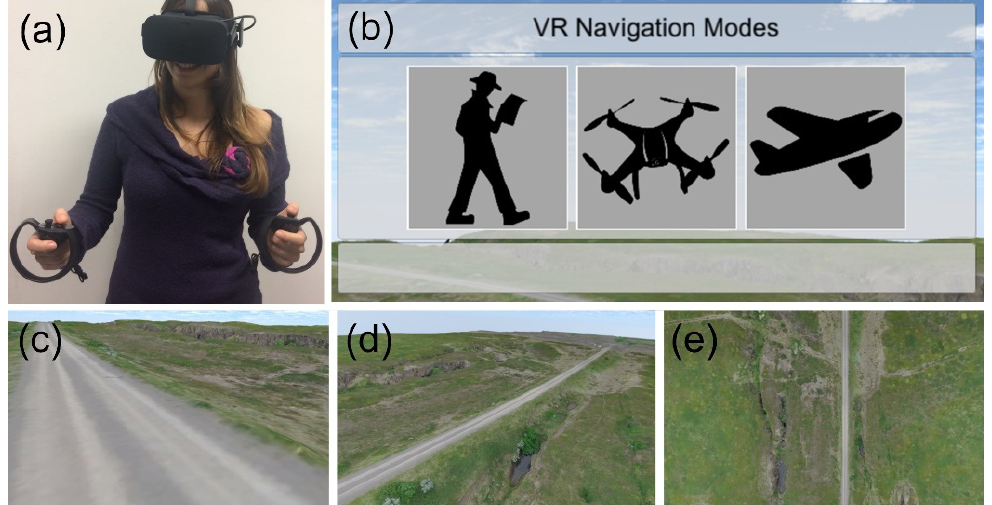
Figure 1. ( a ) User experiencing geological exploration. The VR headset and the input peripherals belong to the Oculus Rift. ( b ) The three exploration modes available in our application; ( c ) walk; ( d ) drone; and ( e ) Flight modes; road for scale.